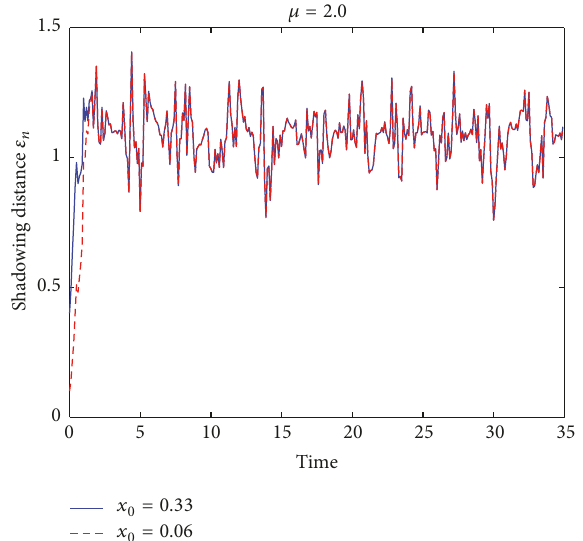
Figure 5: Convergence of the shadowing distance 𝜀 𝑛 with different starting